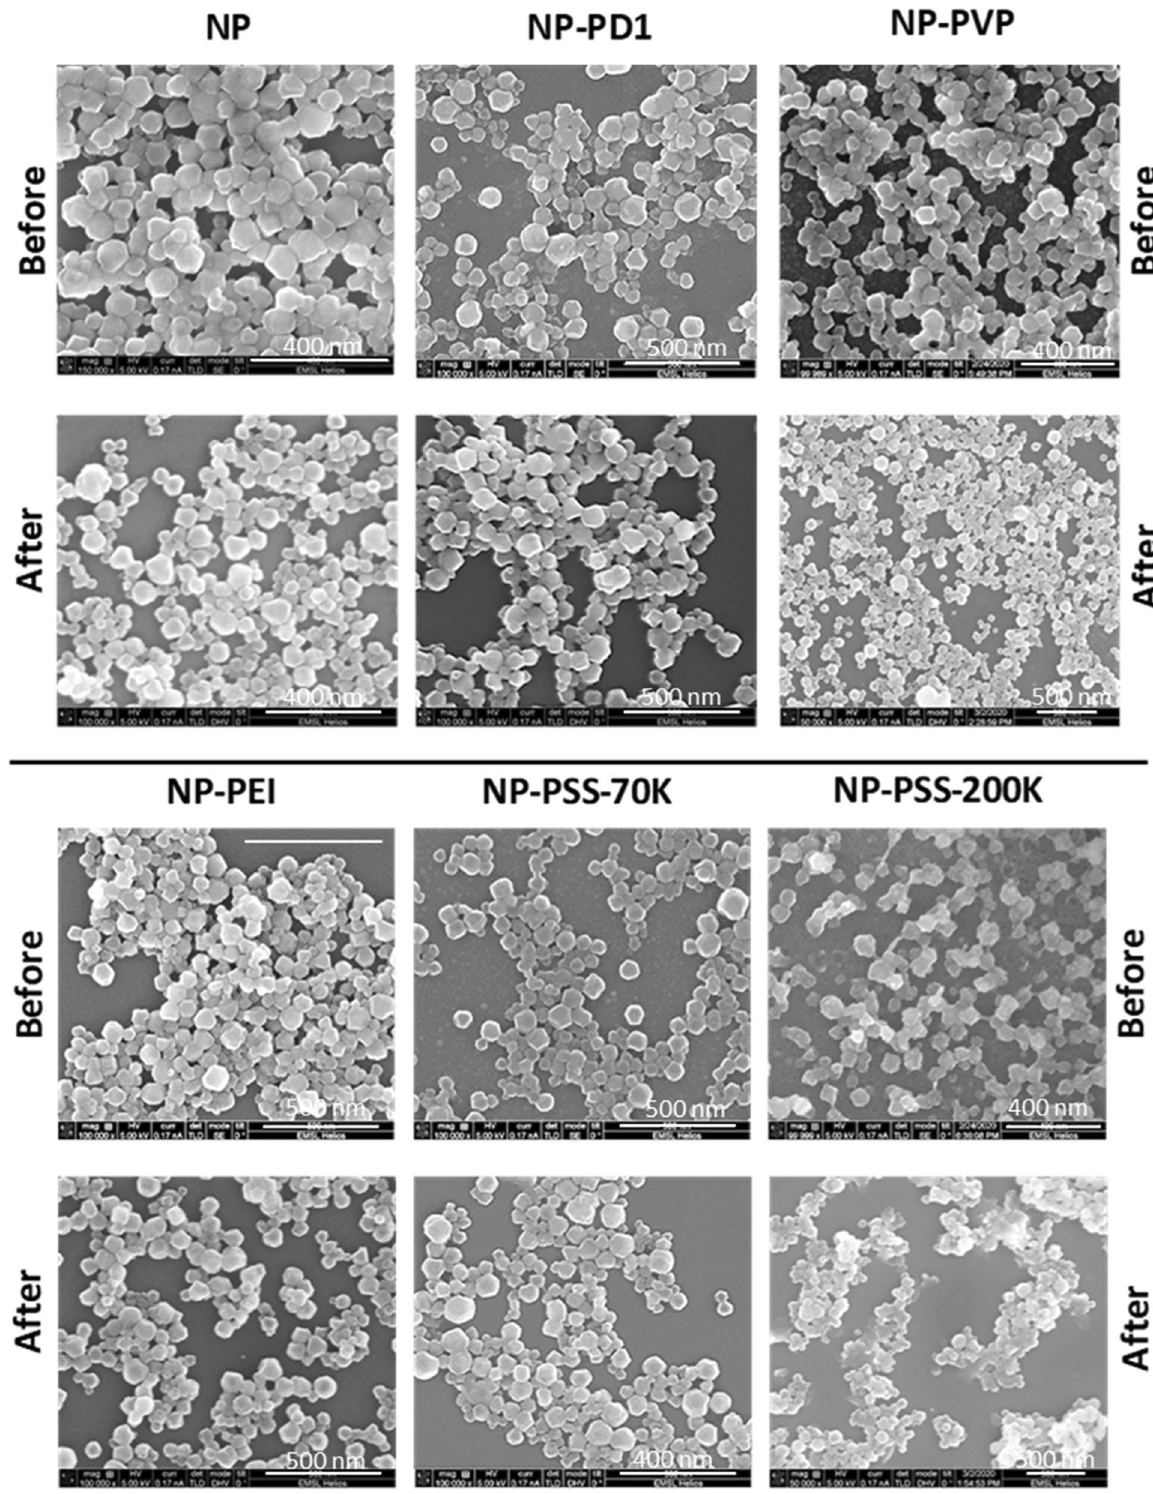
Figure 2. SEM images of MOF nanoparticles with different polymer coatings before and after Accusand column transport